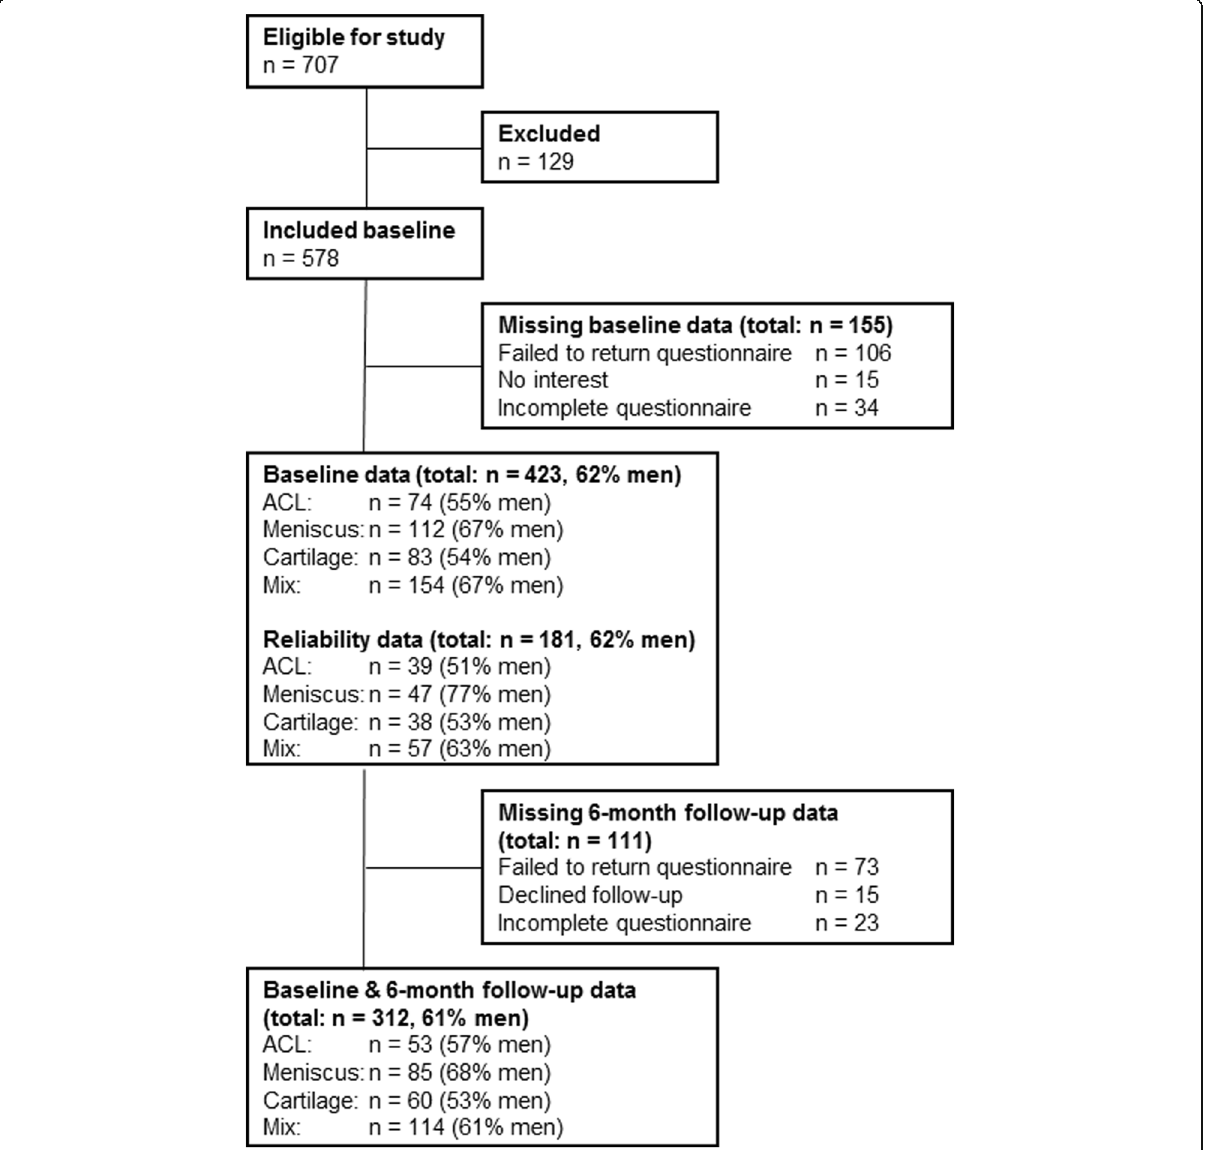
Fig. 2 Selection algorithm showing patient eligibility and the available sample sizes for assessing the measurement properties of the German